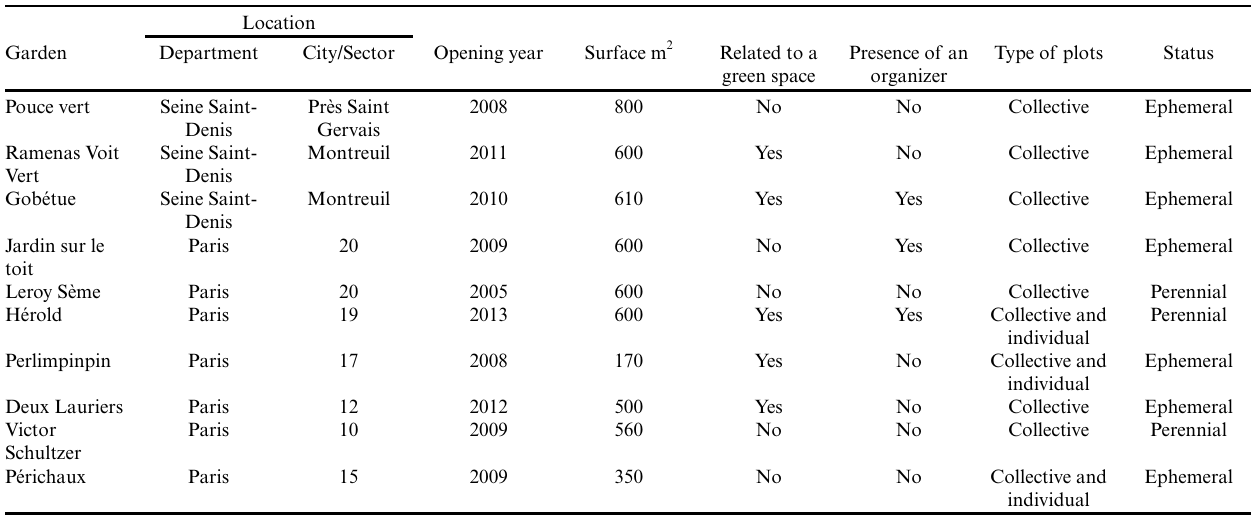
Table 1. Features of the studied community gardens Location